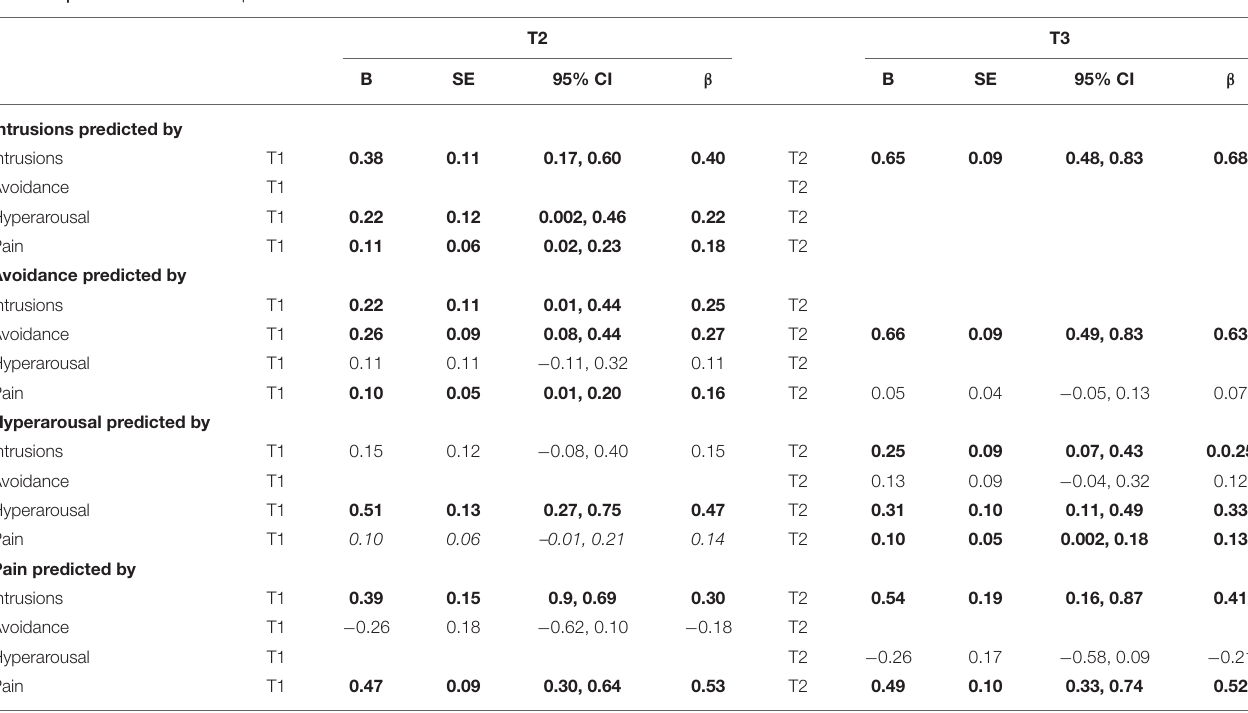
TABLE 2 | Constrained model of pain and PTSD-clusters over